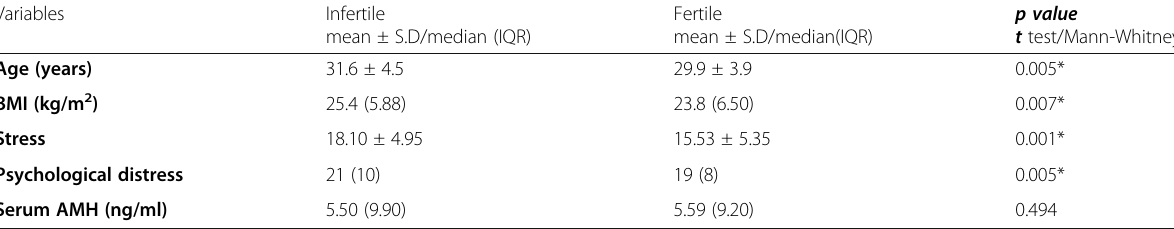
Table 1 Summary of study variables among infertile and fertile women